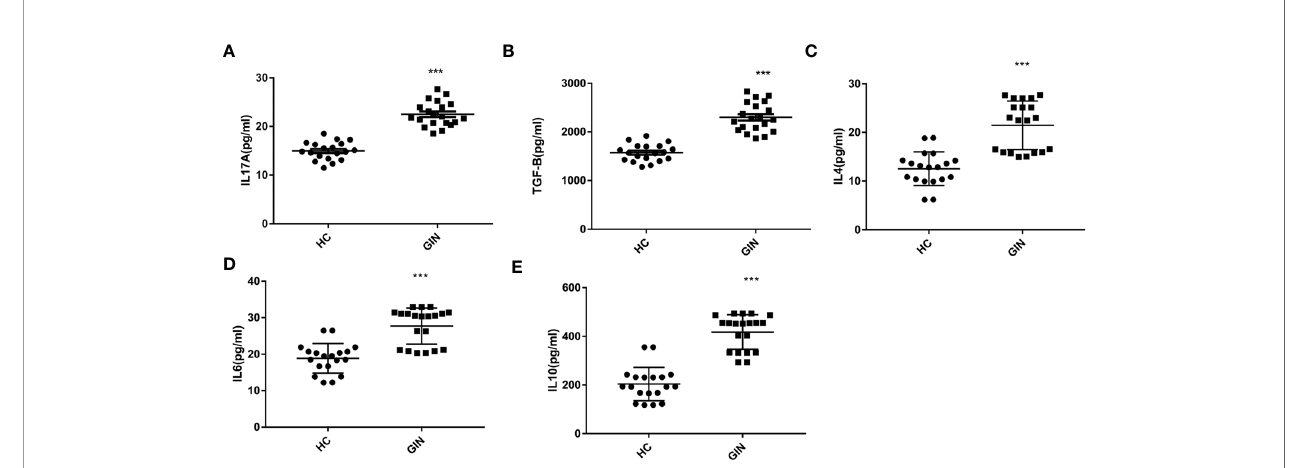
FIGURE 4 | (A) Levels of IL-17A in the plasma of gingivitis patients and healthy controls. (B) Levels of TGF- b in the plasma of gingivitis patients and healthy controls. (C) Levels of IL-4 in the plasma of gingivitis patients and healthy controls. (D) Levels of IL-6 in the plasma of gingivitis patients and healthy controls. (E) Levels of IL-10 in the plasma of gingivitis patients and healthy controls. *** P < 0.001 versus healthy control.